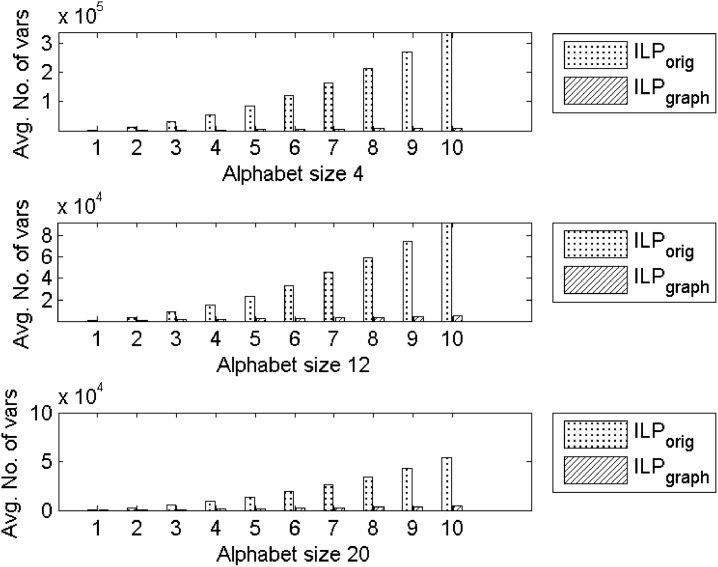
Comparison of average number of variables between ILPorig and ILPgraph for Group4 dataset.Top: Alphabet size 4. Middle: Alphabet size 12. Bottom: Alphabet size 20.